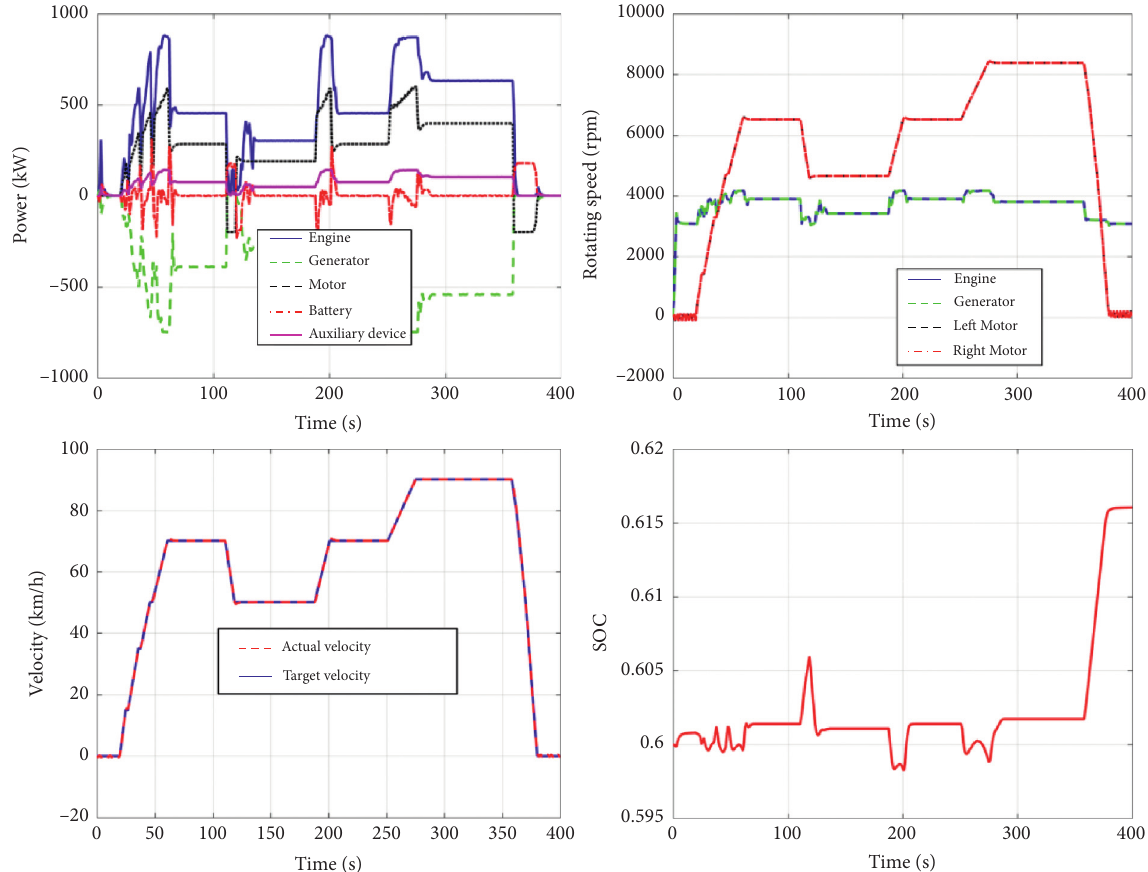
Figure 15: The results of power, rotating speed, velocity, and SOC of real-time